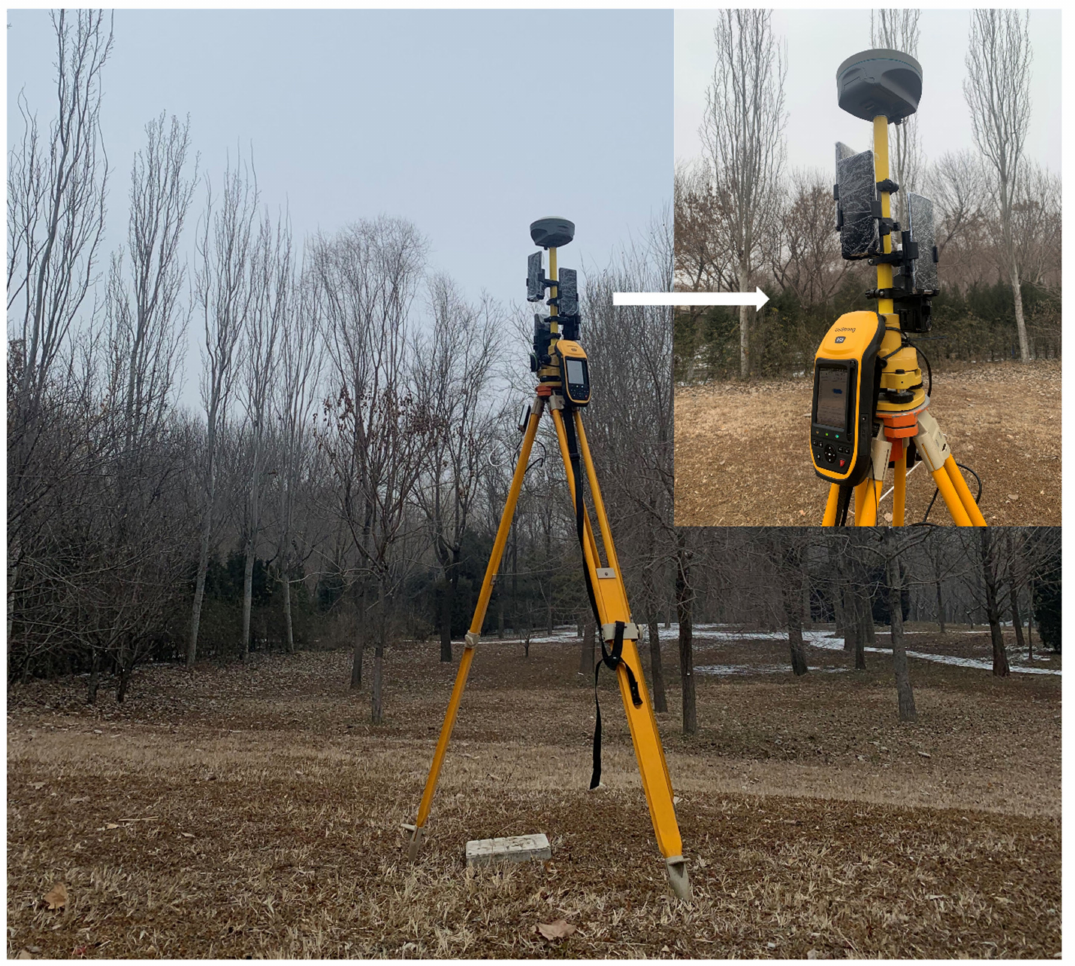
Figure 1. Arrangement of GNSS